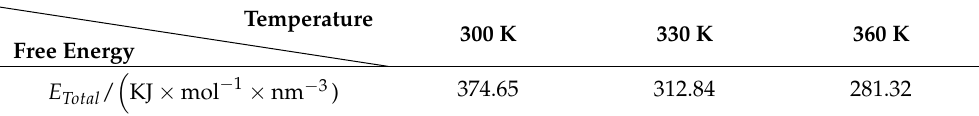
Table 7. Variation of interfacial tension (mN · m − 1 ) at different temperatures.